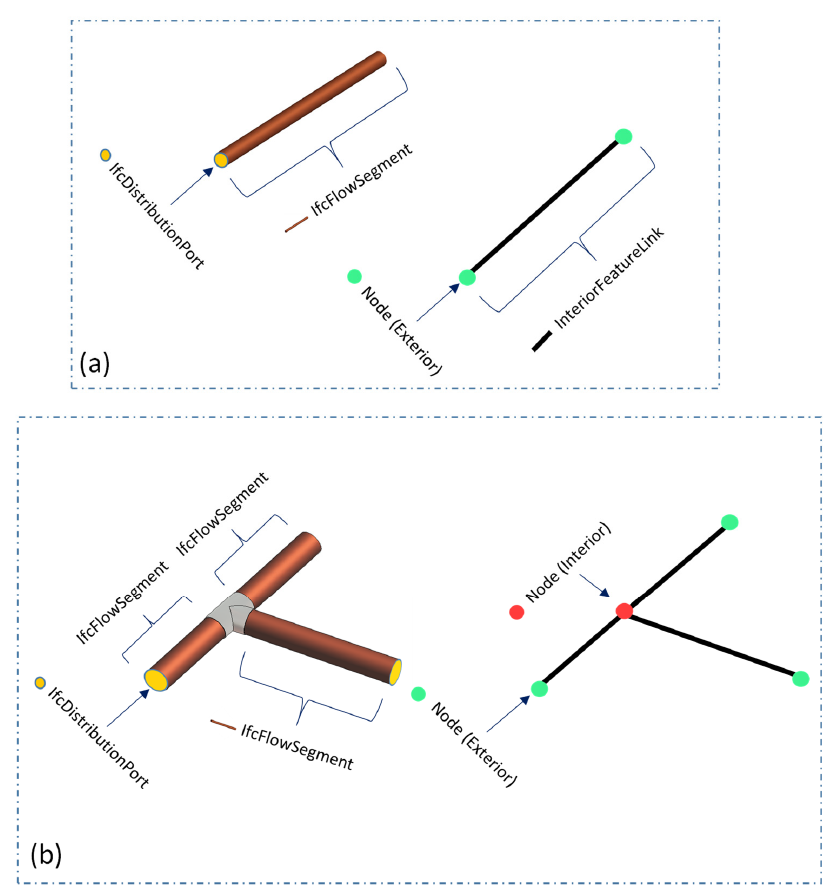
Figure 8. Representation of the IfcFlowSegment with two IfcDistributionPorts ( a ) scenario 1 and ( b ) scenario 2, showing the end connections of the utility infrastructure.